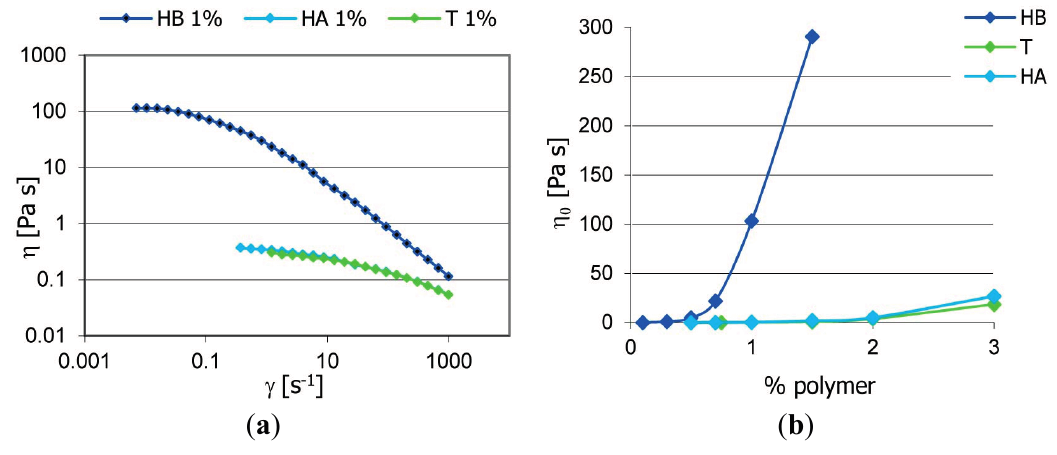
Figure 4. ( a )Viscosity trends vs . the shear rate of HA, HB and TSP at 1% w / w ; ( b ) η 0 values as a function of polymer